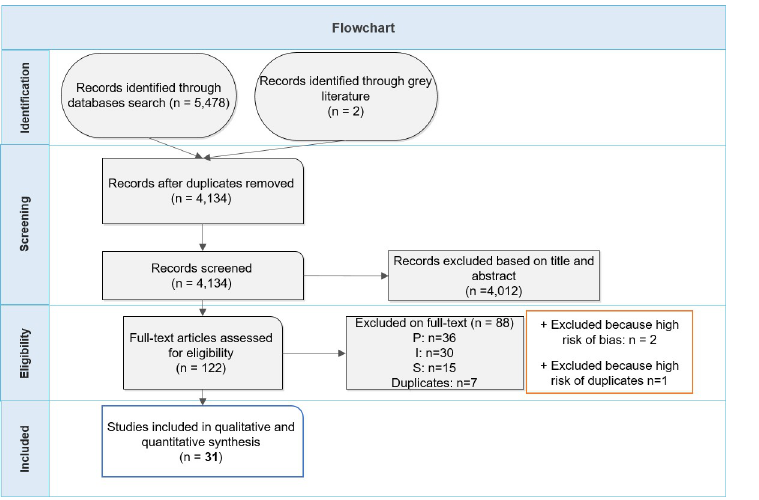
Fig 1. Flowchart of the inclusion process for study